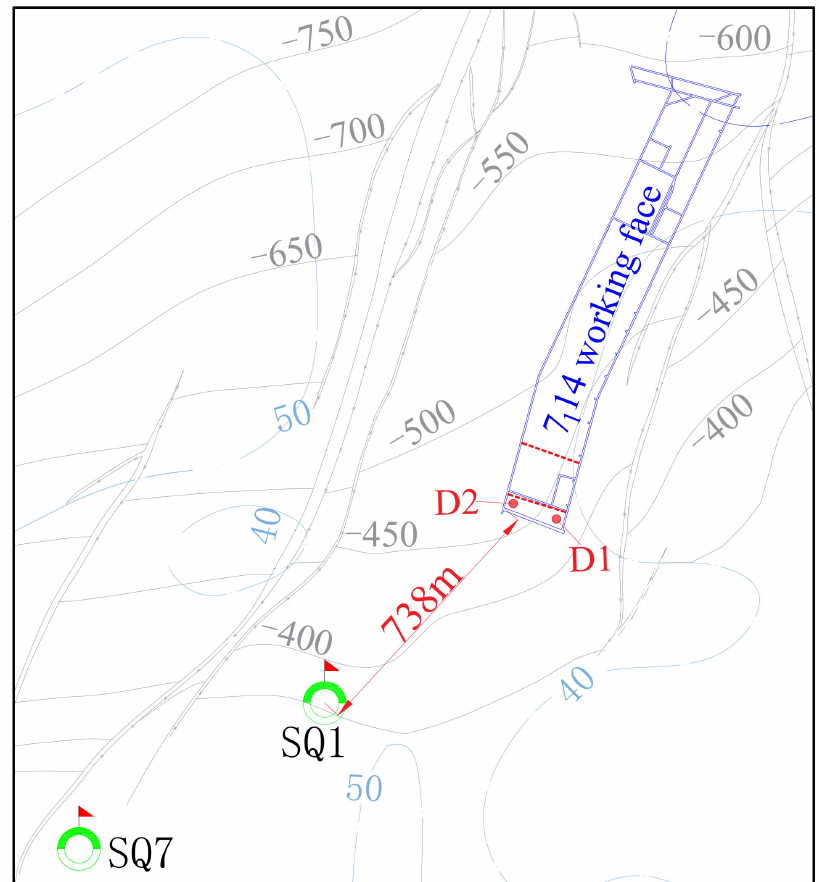
Figure 8. Location of detecting borehole in 7 1 14 working